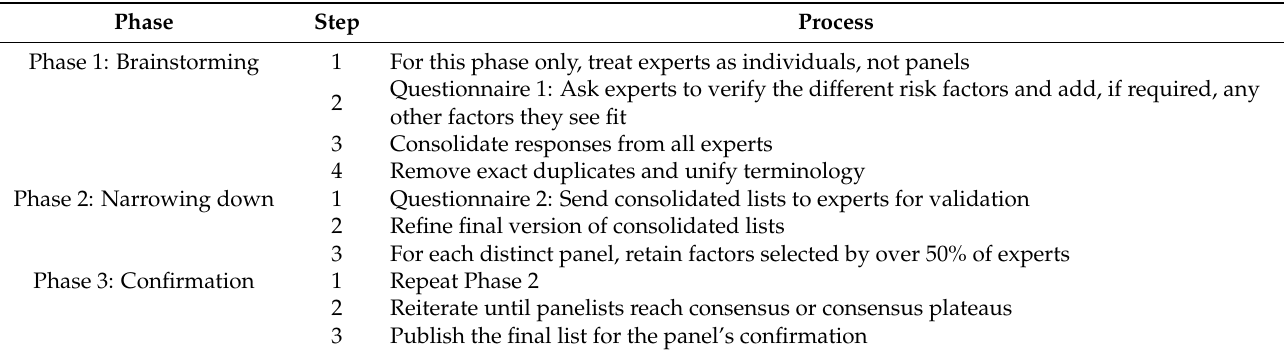
Table 5. Delphi study